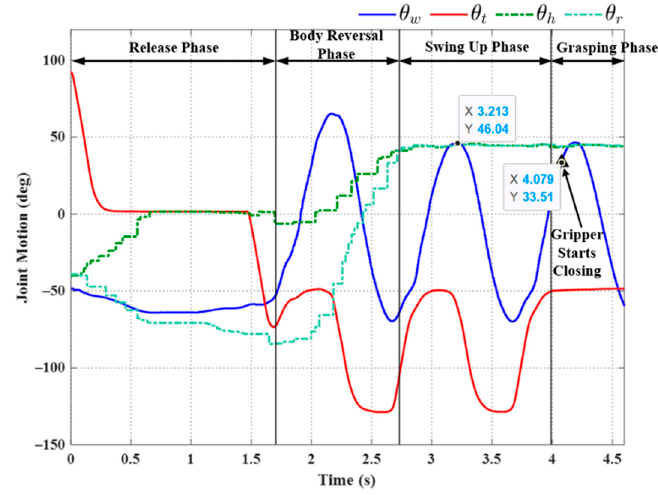
Figure 18. Experimental results: joint motion in Experiment (c).